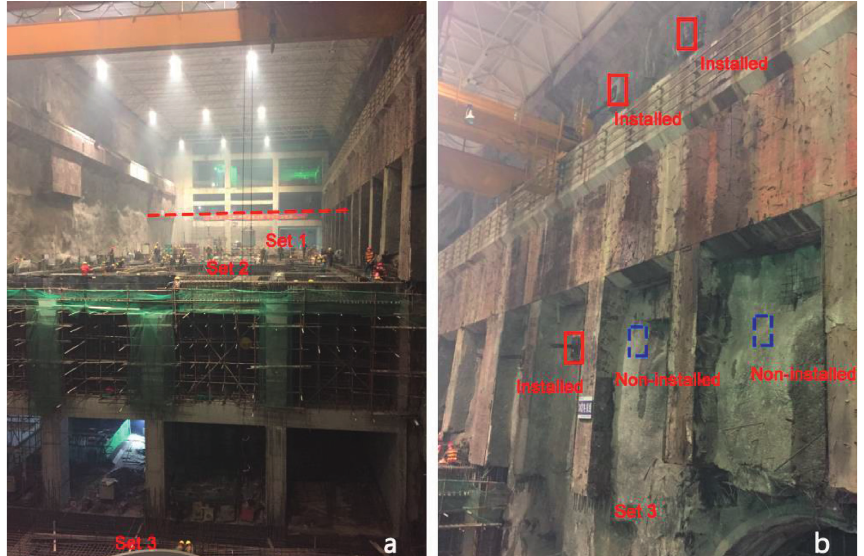
Figure 14: The construction site of the main powerhouse cavern (a) and the location of the anchor heads in the sidewall